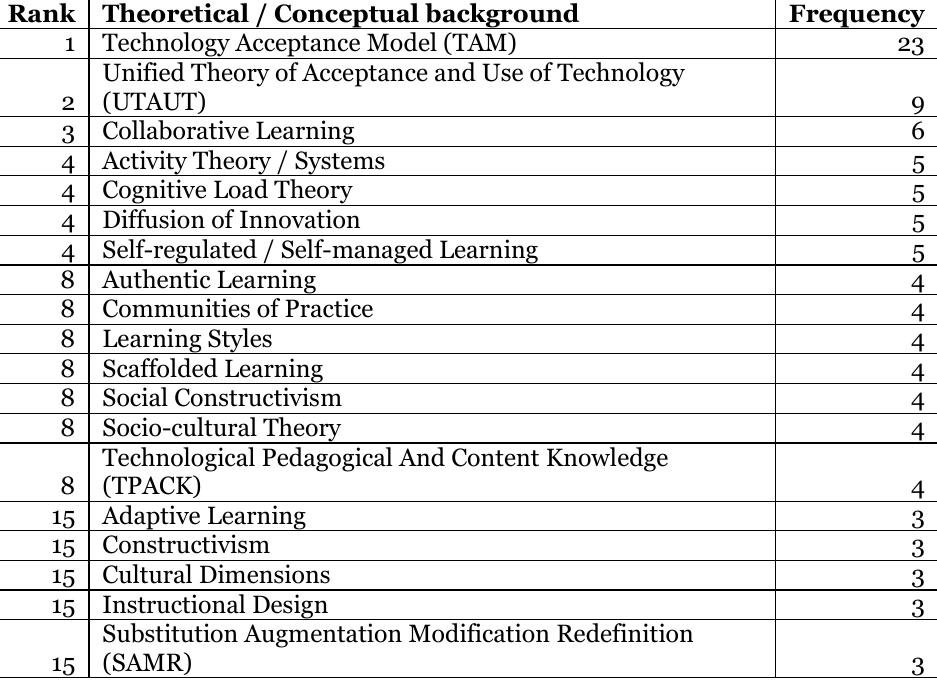
Distribution of Most Common Theoretical or Conceptual Backgrounds Rank Theoretical / Conceptual